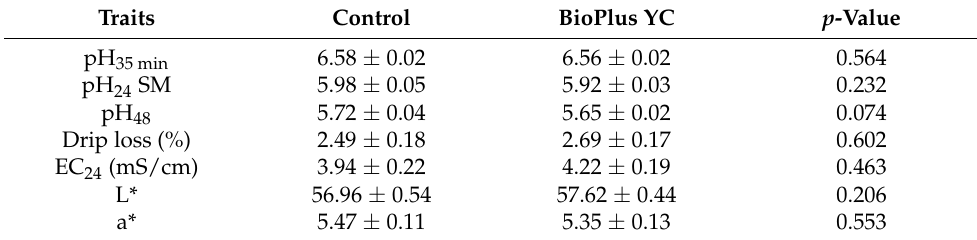
Table 6. Meat quality and basic chemical